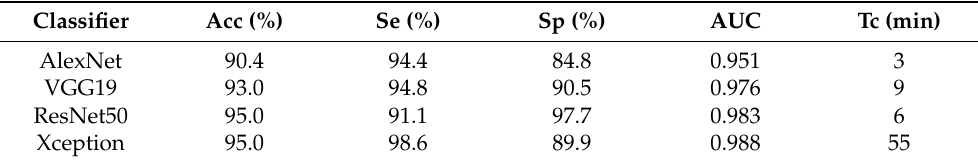
Table 3. Performance of four types of neural networks in the ST-MFCC